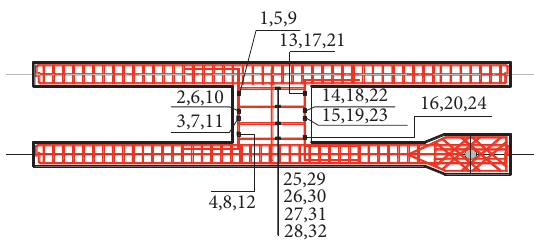
Figure 9: Layout of steel strain gauges.